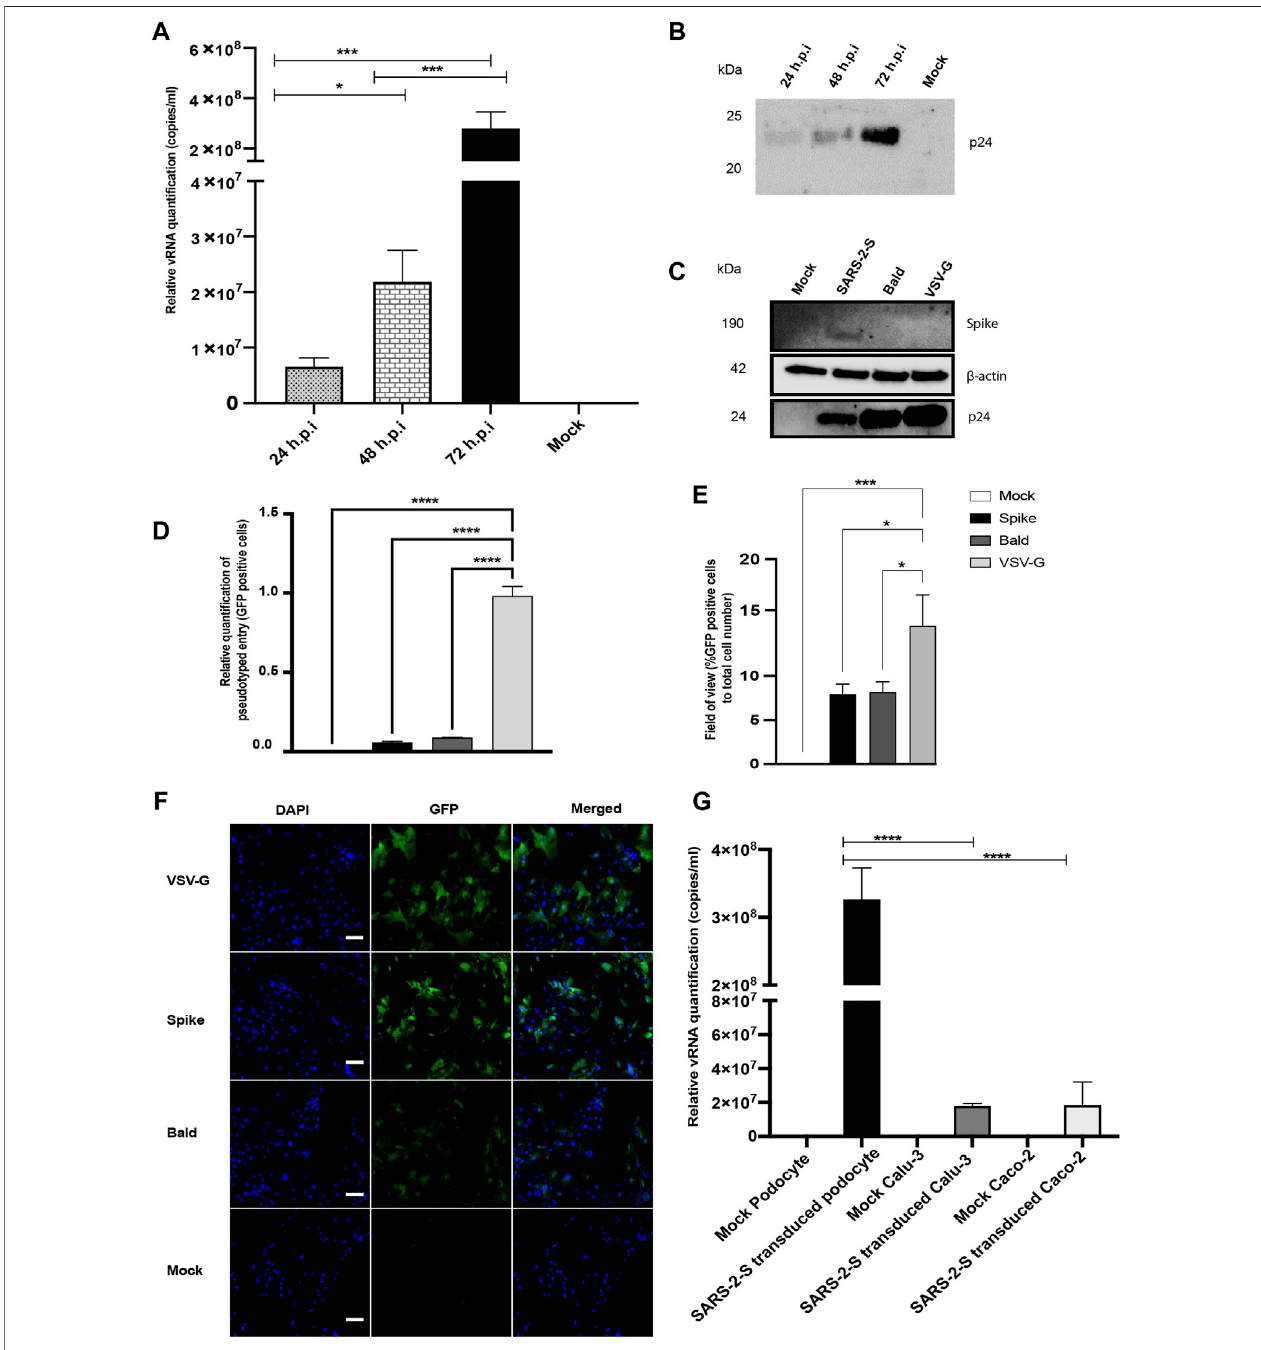
FIGURE 2 | SARS-CoV-2 S-pseudovirus infection of human iPS cell-derived podocytes . (A) qRT-PCR analysis using Lenti-X titration kit revealed time-dependent increase in the copies of viral RNA in human iPS cell-derived podocytes infected with the S-pseudovirus. (B) Western blot con fi rmed time-dependent increase of S-pseudovirusparticlesinhumaniPScell-derivedpodocytes,wherep24(GAG) isamarkerforthepseudoviralcapsidprotein. (C) Westernblotfromcelllysatesofmock andinfected(S-,BaldandVSV-Gpseudotyped)podocytescon fi rmingthepresenceofSARS-CoV-2spikeproteinsinS-pseudotypedinfectedpodocytes,HIVviral proteinp24visibleinallpseudotypedinfectedcellsbutnotinmockand β -actinusedasloadingcontrolpresentinallcelllysates (D) qRT-PCRdatameasuringthelevelsof EGFPusingGFPspeci fi cprimers (E) PercentageofEGFPpositivecellscomparedtototalcellnumber (F) Immuno fl uorescentstainingshowingDAPI,EGFPandmerged in pseudotyped infected cells and mock. Scale bar: 100 µm. (G) qRT-PCR results showing signi fi cantly higher number of S-pseudotyped copies in human iPS cell- derived podocytes compared to Calu-3 and Caco-2 cell lines, 72 h post infection (h.p.i.). The statistical test was done by One-way ANOVA with Sidak ’ s multiple comparison test. Error bars indicate standard deviation of the mean. Only p values of 0.05 or lower were considered statistically signi fi cant ( p > 0.05 [ns, not signi fi cant], p < 0.05 [*], p < 0.01 [**], p < 0.001 [***], p < 0.0001 [****]).